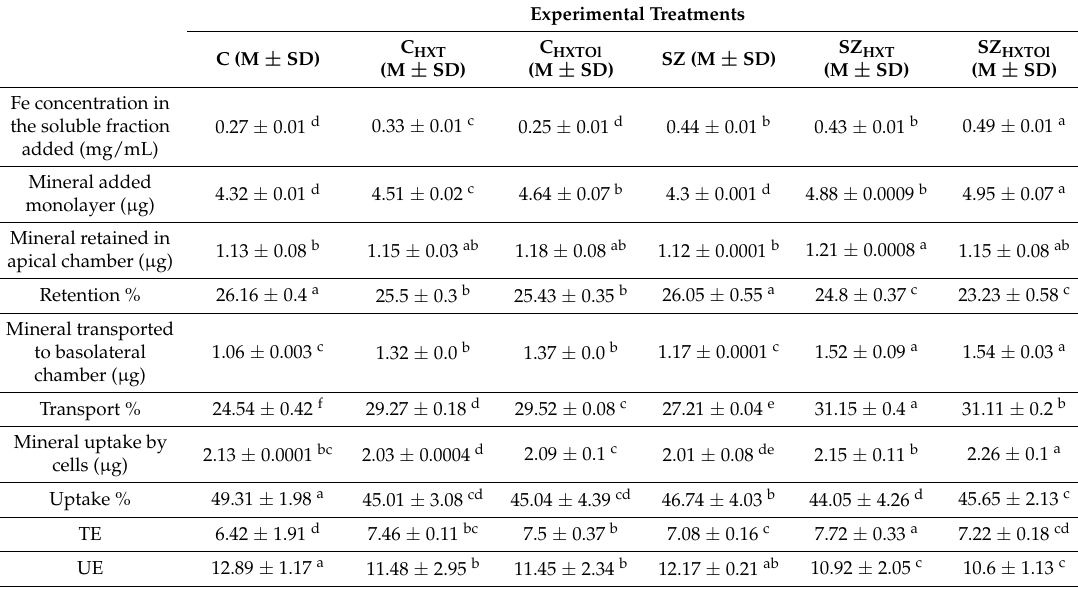
Table 5. Fe retention, transport, and cellular uptake in enriched emulsions.